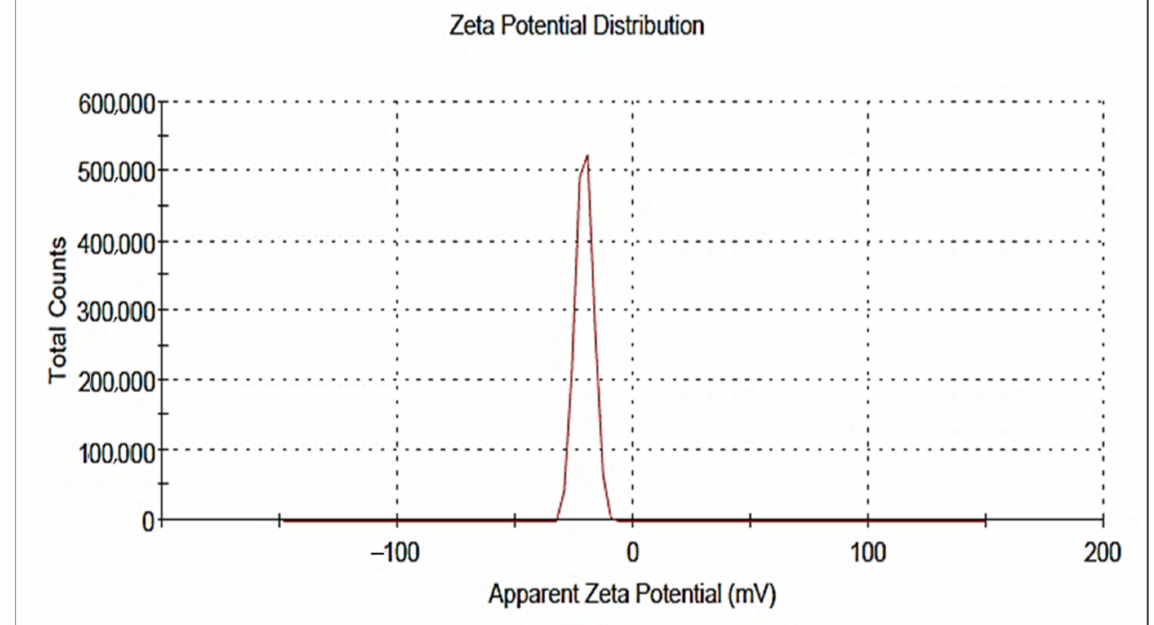
Figure 7. Zeta potential of biosynthesized zinc oxide